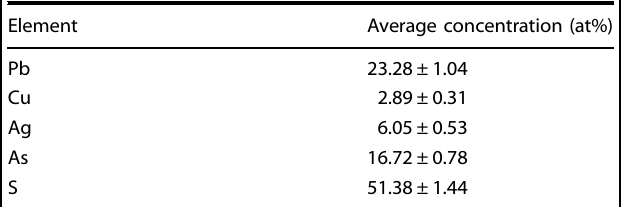
Table 2. Compositional stoichiometry of lengenbachite from XPS quanti fi